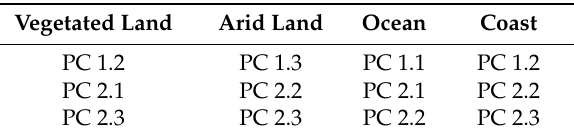
Table 2. List of the first three neural network (NN) inputs, selected for the four surface typologies, based on principal component analysis